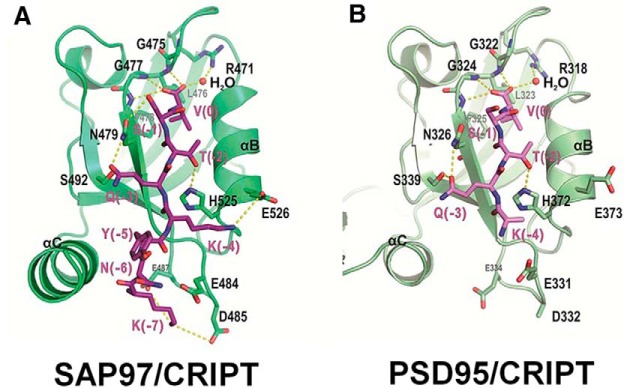
Structural model of SAP97 PDZ3 in complex with the CRIPT C-terminal tail. A, The SAP97 PDZ3/CRIPT peptide complex structure modeled using the experimentally derived PSD95 PDZ3/CRIPT complex structure (PDB id:1BE9) depicted in B. In these drawings, the CRIPT peptide is depicted in purple.